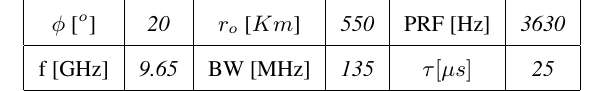
Table 2. The X-band SAR sensor based on DLR’s TerraSAR-X to test VCA performance. φ [ o ]